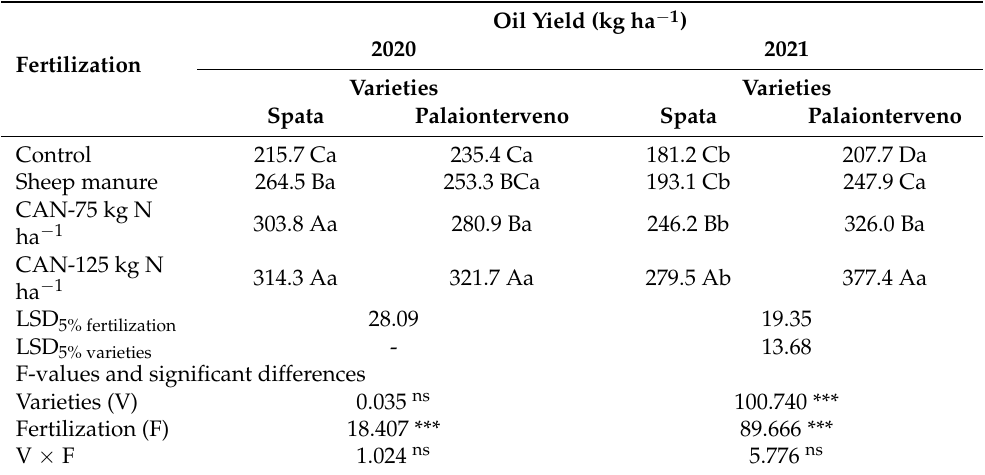
Table 7. Effects of two milk thistle varieties (Palaionterveno and Spata) and fertilization regimes (sheep manure and inorganic fertilizer) on oil yield of milk